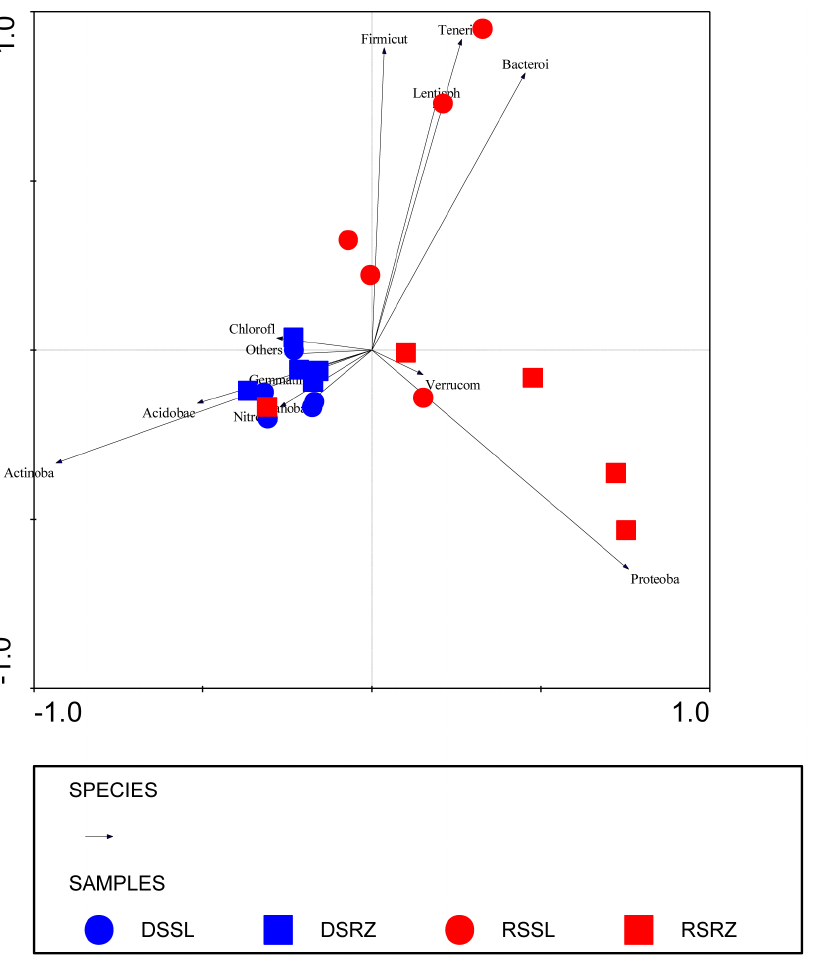
Figure 6. PCA of the 16S libraries based on taxonomic affiliation of reads determined by mothur. Samples are bulk soil during the rainy season (RSSL), bulk soil during the dry season (DSSL), rhizosphere during the rainy season (RSRZ) and rhizosphere during the dry season (DSRZ). The most common phyla are: Acidobacteria (Acidobac), Actinobacteria (Actinoba), Bacteroidetes (Bacteroi), Chloroflexi, Cyanobacteria (Cyanoba), Firmicutes (Firmicut), Gemmatimonadetes (Gemmati), Lentisphaerae (Lentisph), Nitrospirae (Nitro), Others, Proteobacteria (Proteoba), Tenericutes (Tener) and Verrucomicrobia (Verrucom).